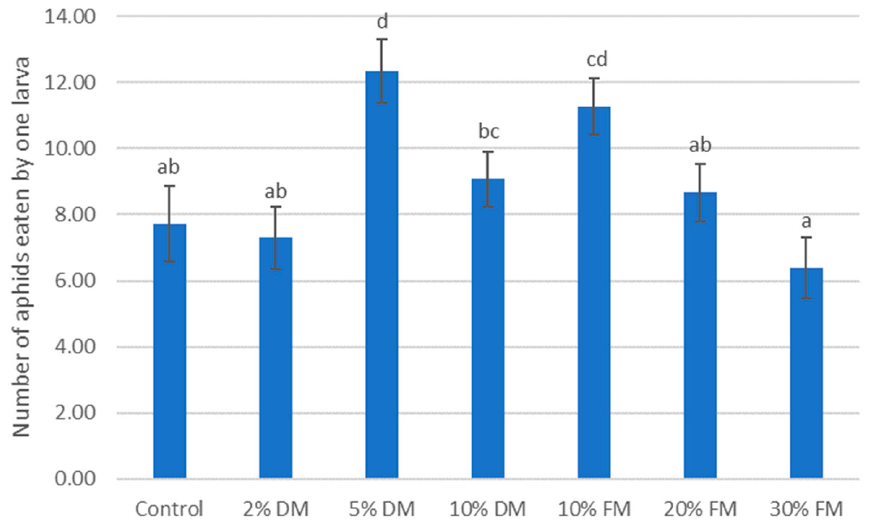
Figure 2. Mean number of aphids eaten by one L3 larvae of C. septempunctata during the period of observation (12 h) after the application of water extracts made from the fresh (FM) and dried (DM) parts of tarragon. Means ± SE marked by different letters are statistically different ( α = 0.05).